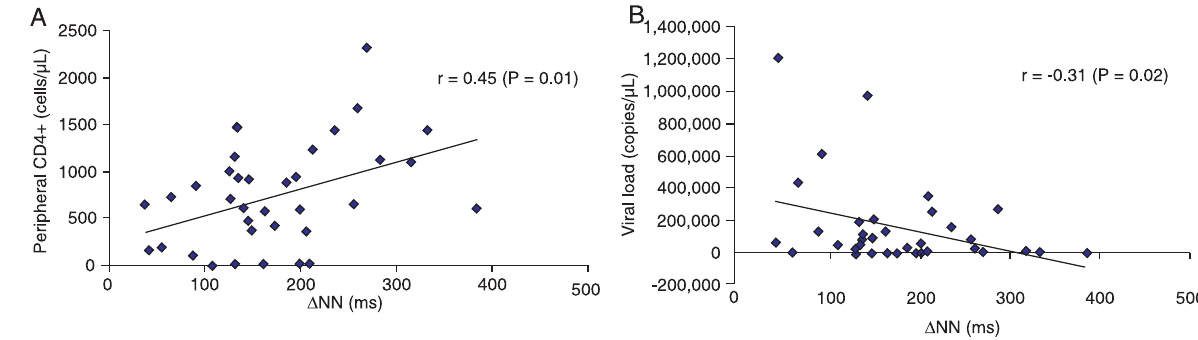
Figure 2. A , Plot of CD4+ cell count in a peripheral blood sample vs maximal circadian hourly averaged RR interval variation (∆NN). Note the significant Pearson positive correlation indicating the association between current autonomic status and 24-h cardiac auto - nomic modulation. B , Plot of viral load in a peripheral blood sample vs maximal circadian hourly averaged RR interval variation (∆NN). Note the significant Pearson negative correlation, indicating the association between amount of circulating virus and 24-h cardiac autonomic